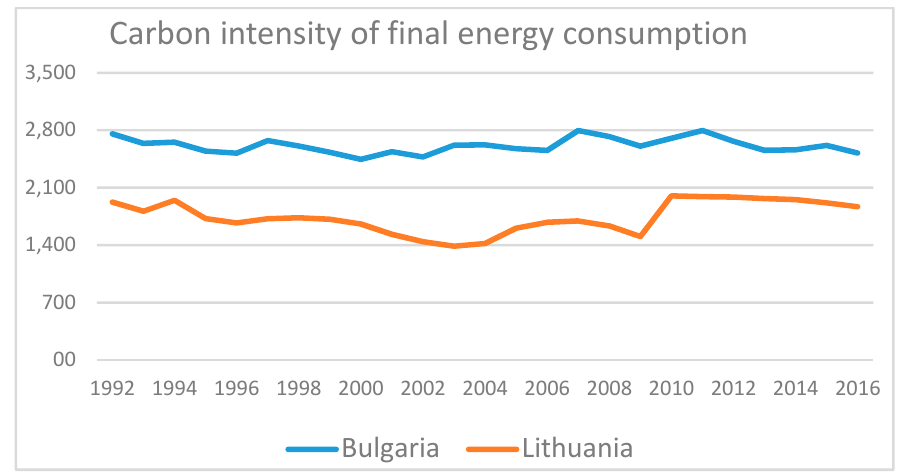
Figure 7. GHG emission per final energy supply in Bulgaria and Lithuania, CO2eq/M€'10. Source: [39,40].